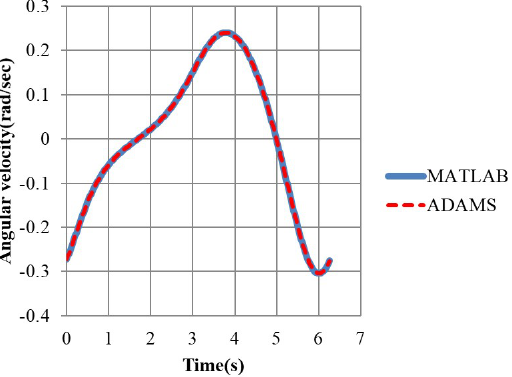
Figure 6. Comparison of our modeling computation with that of ADAMS on ω 3 .